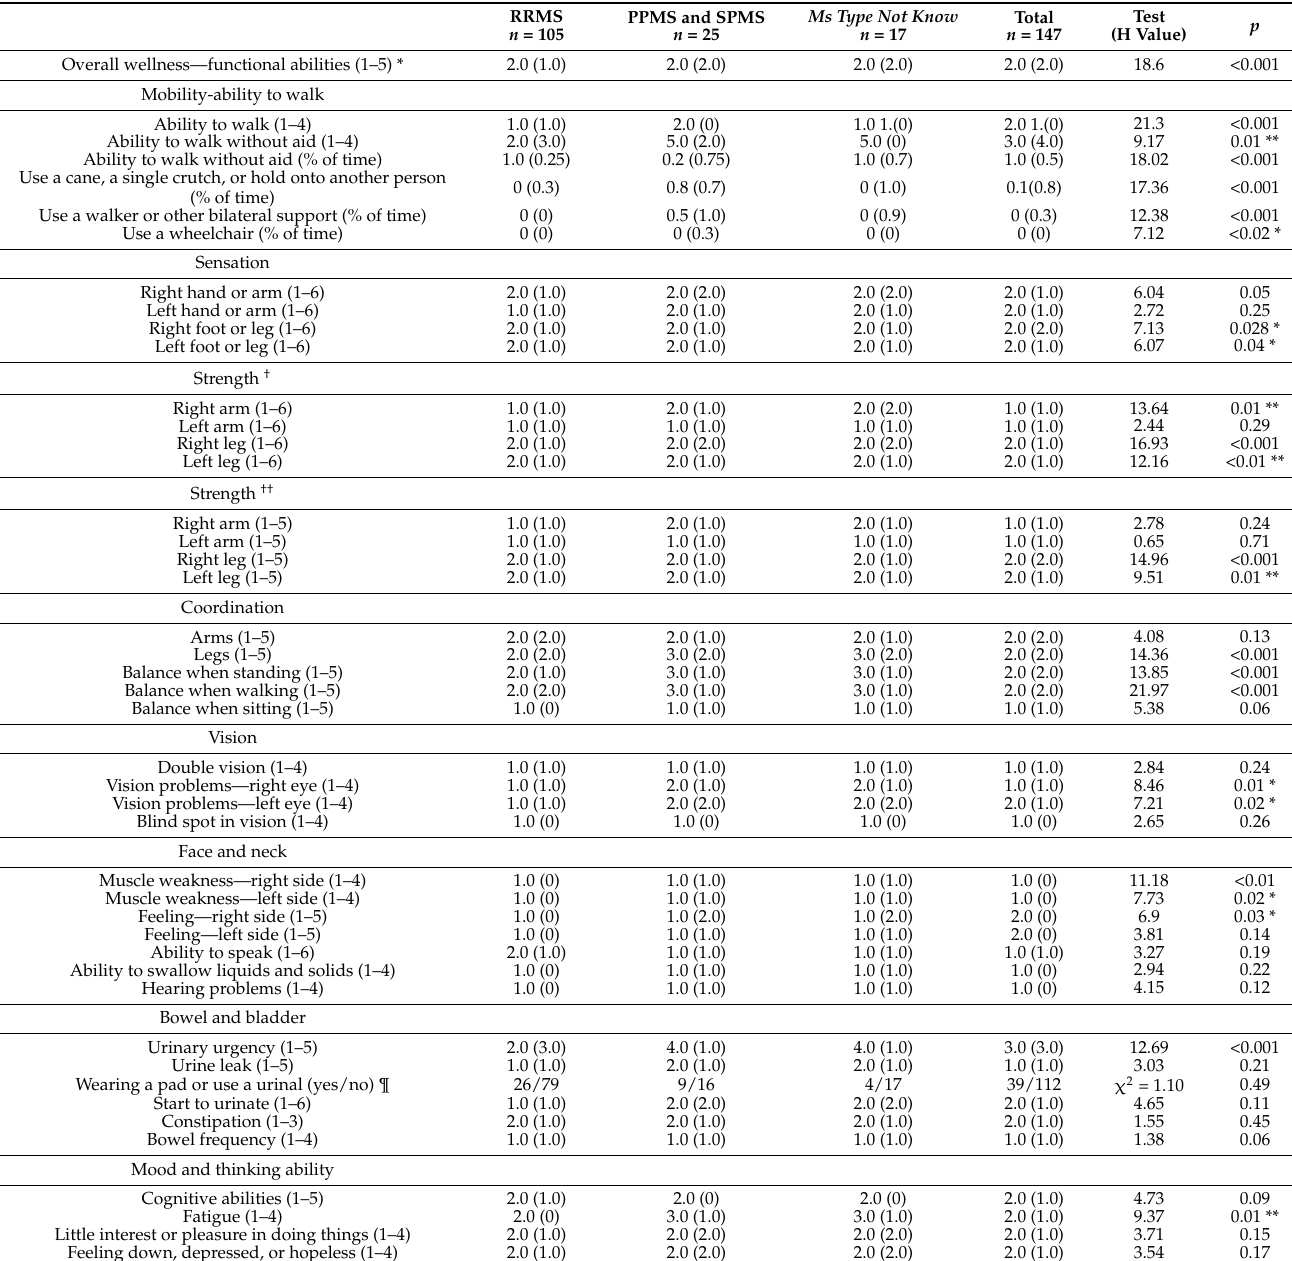
Table 5. Disability status and symptom-level analysis with regard to MS